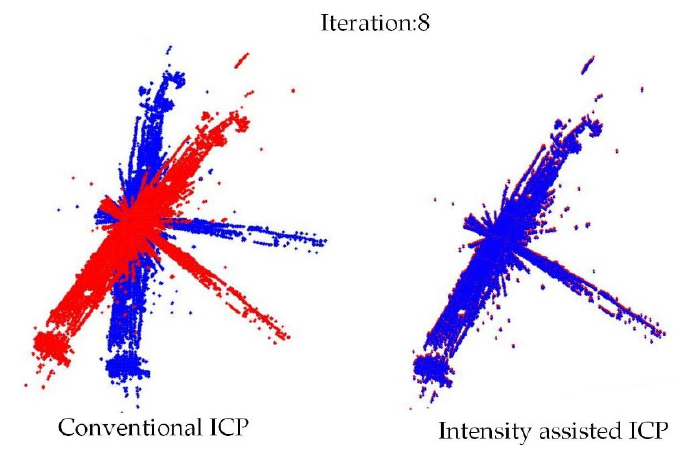
Figure 7. Visual comparison of convergence speed for conventional ICP and intensity-assisted ICP. The blue point cloud shows the source frame taken under 0° and red target frame under 30°. On the 8th iteration intensity-assisted ICP has converged but conventional ICP has not.